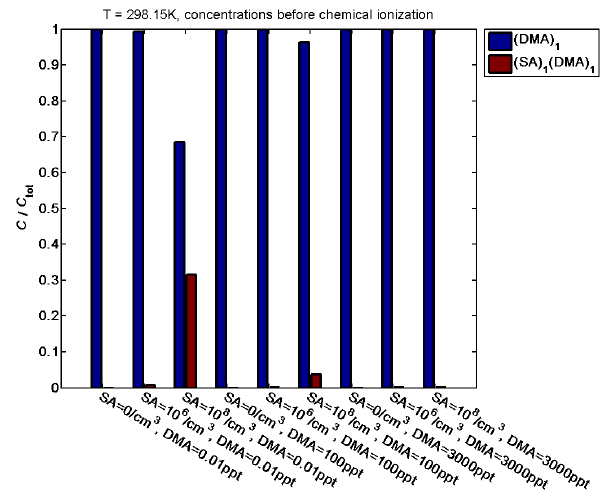
Figure 1. Relative concentrations before chemical